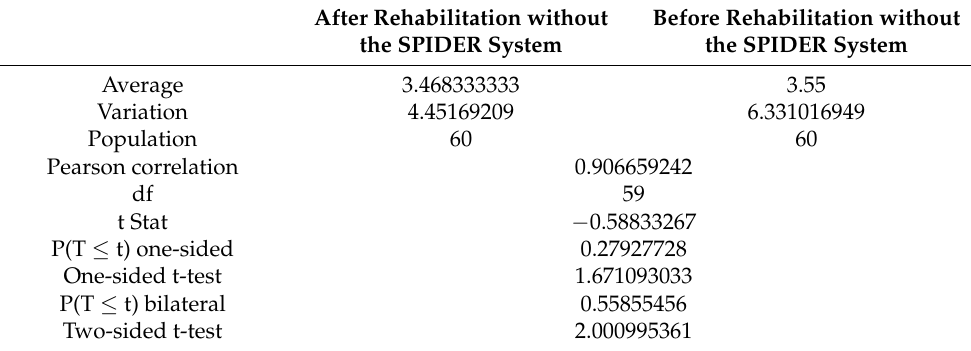
Table 5. The results of the statistical analysis of the average tilt before and after rehabilitation without the SPIDER system.